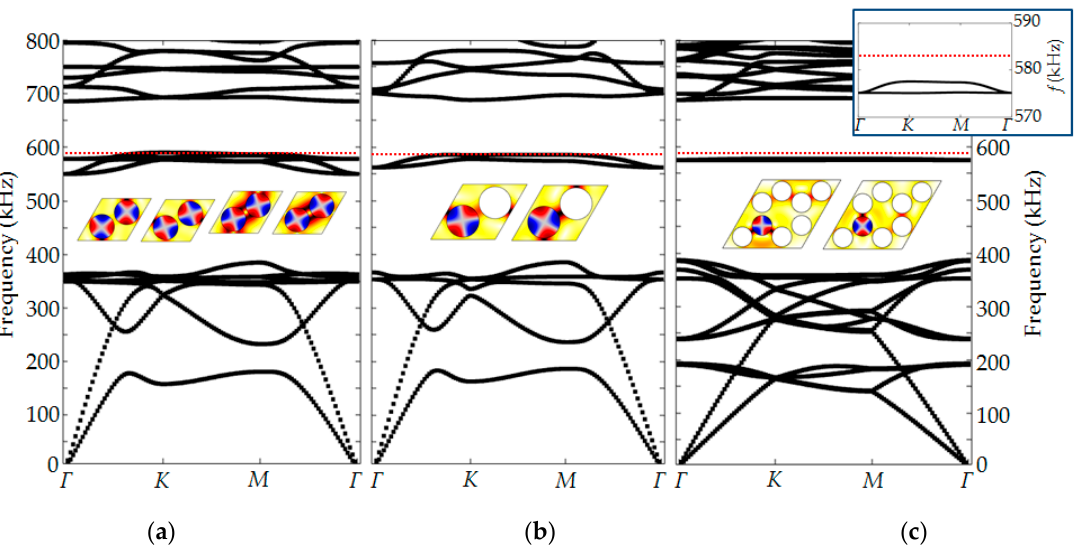
Figure 5. Band diagrams of honeycomb type phononic structure with liquid inclusions: ( a ) All the structure scatters are filled by a liquid; ( b ) every second scatter of a translation cell is liquid-filled; ( c ) a supercell with one liquid inclusion. The inset figure is a zoomed view on a supercell narrowband. The red dotted line shows the second resonant mode of a cylindrical liquid-filled resonator with perfect reflective boundaries. The distribution of displacement and pressure fields within unit cells for the defect eigenmodes are shown for the Γ point ( k = 0).